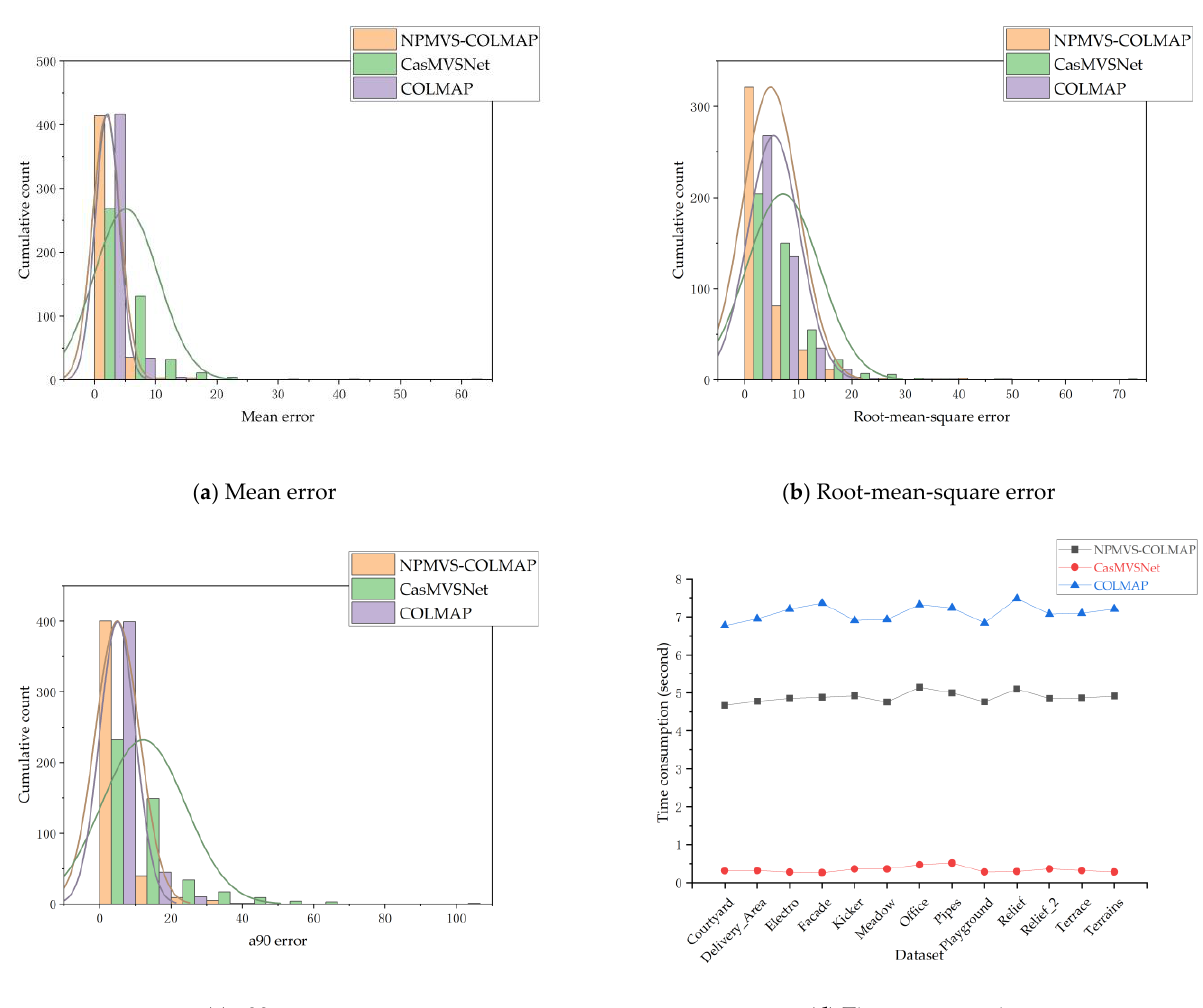
Figure 3. Experimental results of the depth map comparison (lower is better).